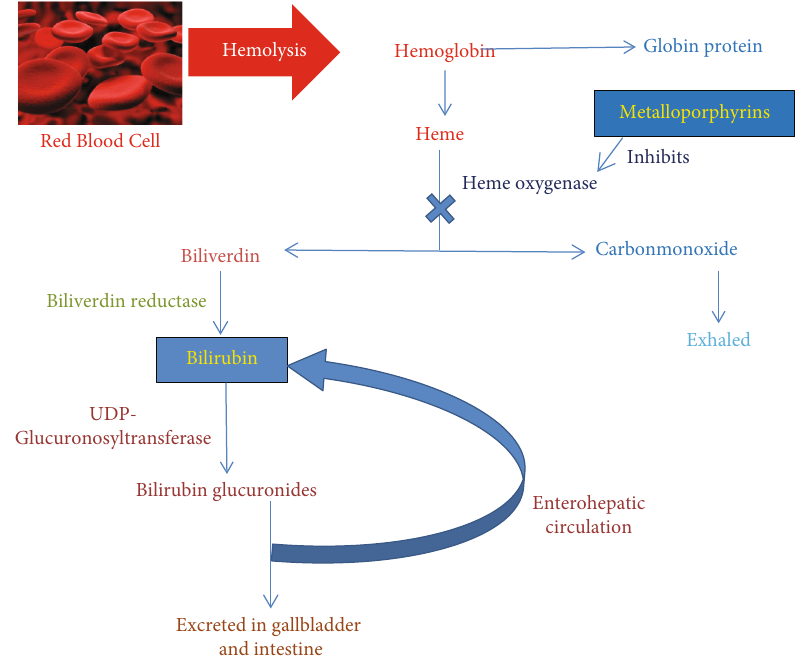
Figure 1: Breakdown of red blood cell. Heme oxygenase enzyme reacts on heme to form biliverdin and eventually bilirubin.